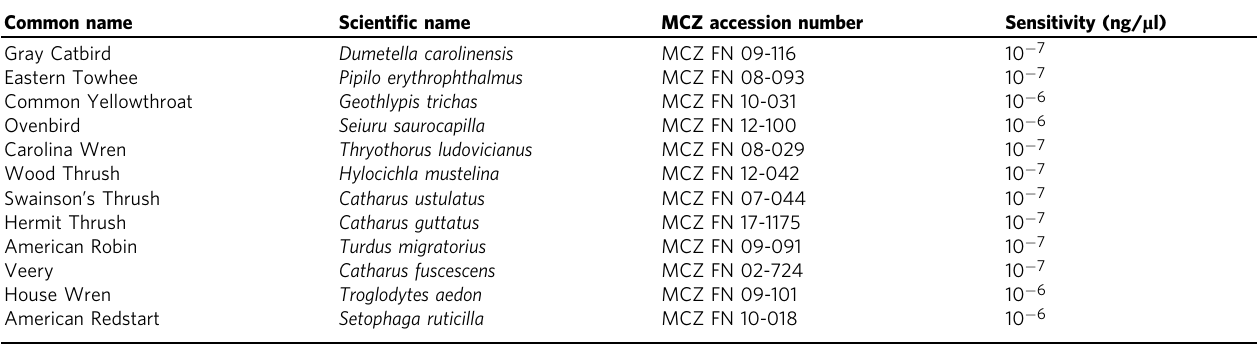
Table 5 Sensitivity of the bird